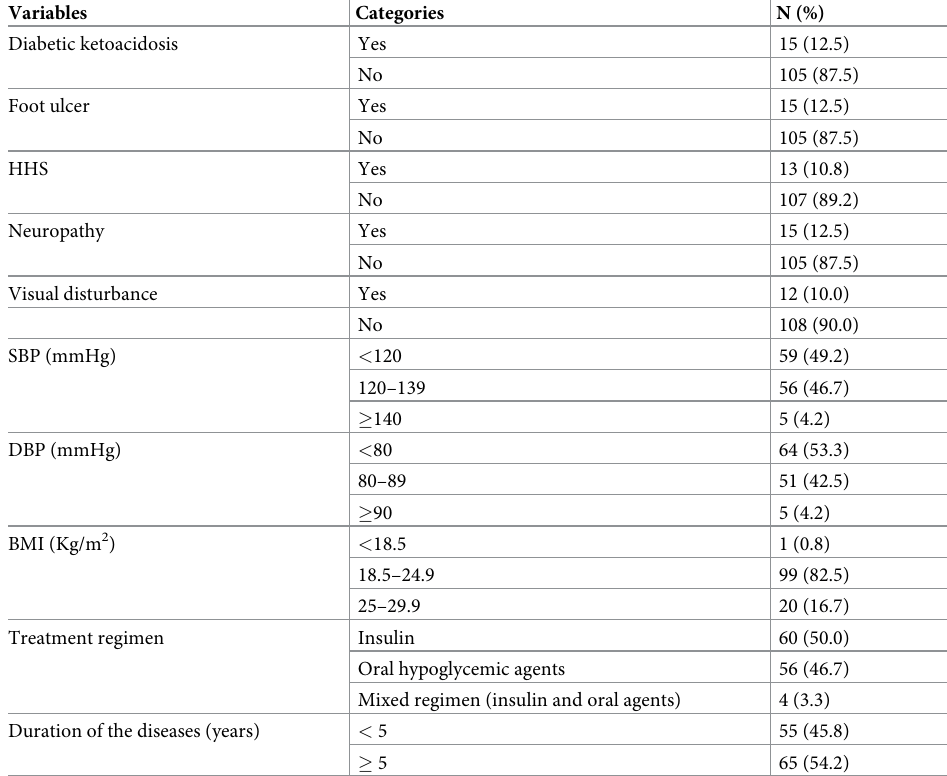
Table 2. Clinical and anthropometric variables of T2DM patients at Dessie comprehensive specialized hospital, Northeast Ethiopia from January to June 2021 (n = 120).